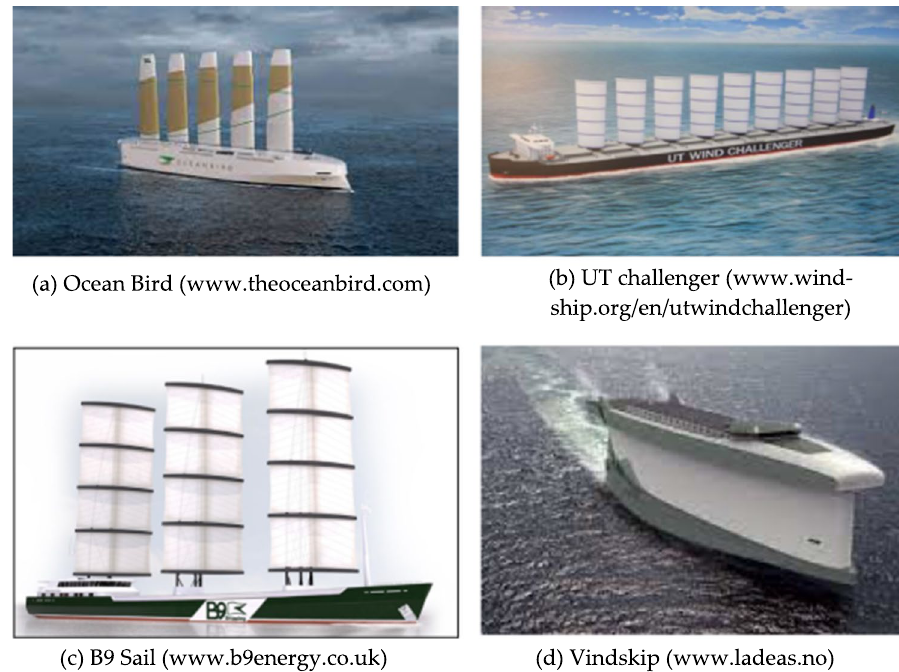
Fig. 4 Ships equipped with wind sail technology. a Ocean Bird (www. theoc eanbi rd. com). b UT challenger (www. wind- ship. org/ en/ utwin dchal lenger). c B9 Sail (www. b9ene